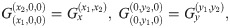
Transport measurements on particles in a box simulated by MonteCarlo dynamics.(A,B and C) show the iFCCS results from corresponding ROI highlighted by concentric circles shown in D. In each ROI, 1 auto correlation function along with 8 cross correlation functions along the three Cartesian axes is shown. For brevity, the Cross correlation functions defined in the text are simplified as G(x1,0,0)(x2,0,0)=Gx(x1,x2),G(0,y1,0)(0,y2,0)=Gy(y1,y2),
G(0,0,φ1)(0,0,φ2)=Gz(φ1,φ2) and G(0,0,0)(0,0,0)=G(0,0). (A) shows the calculated correlation functions in a region where the particles undergo pure diffusion (D = 10−1
μm2/sec). (B) Shows the correlation functions in a region where the particles were subjected to flow (v = 0.4 μm/s) along the Y axis. (C) Shows the correlation functions in a region where the particles are subjected to flow along the Z axis. (D) Shows the superimposed image from the simulated system for 20,000 frames with the regions marked which have been used for calculation in (A), (B) and (C). This overlapping image demonstrates the inhomogeneous nature of the sample. The fitted correlation curves give a diffusion coefficient of (0.89±0.048)×10−1
μm2/sec and flux of (0.36±0.028) μm/sec. For a better visualization and understanding each individual graph has been presented in the supplementary section in S4 Fig.